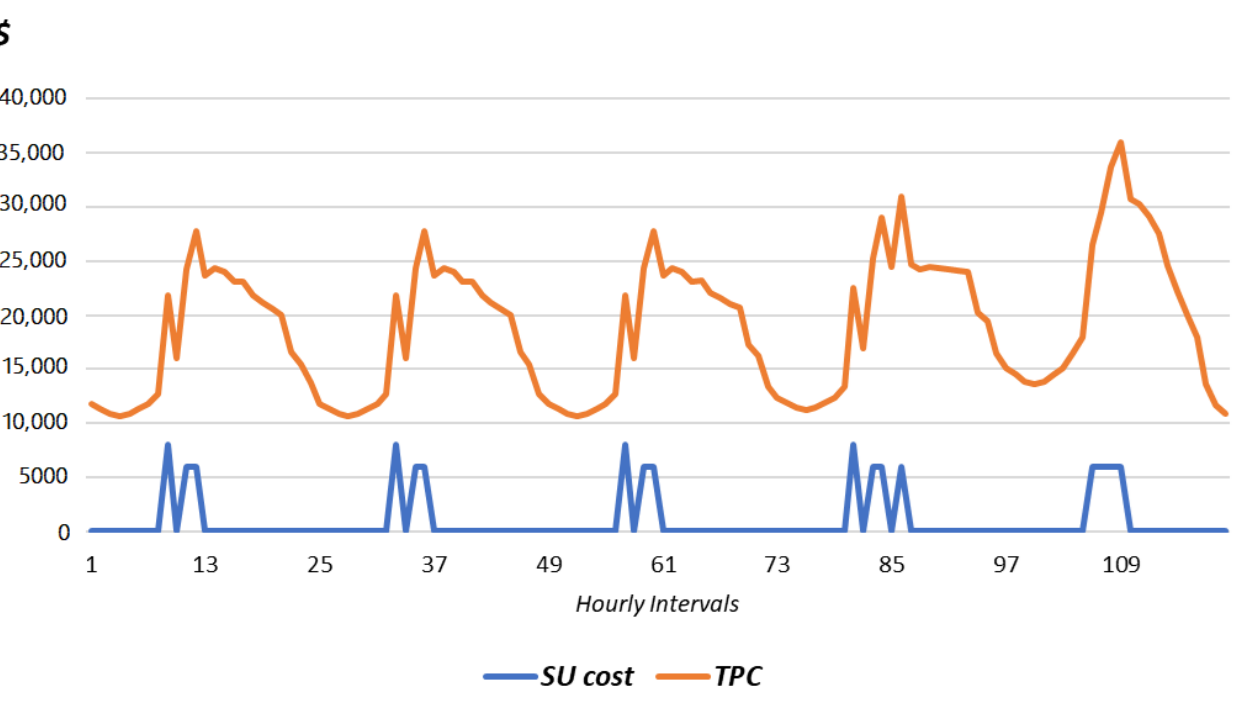
Figure 9. Start-up versus total production cost with the variational Bayes paradigm.